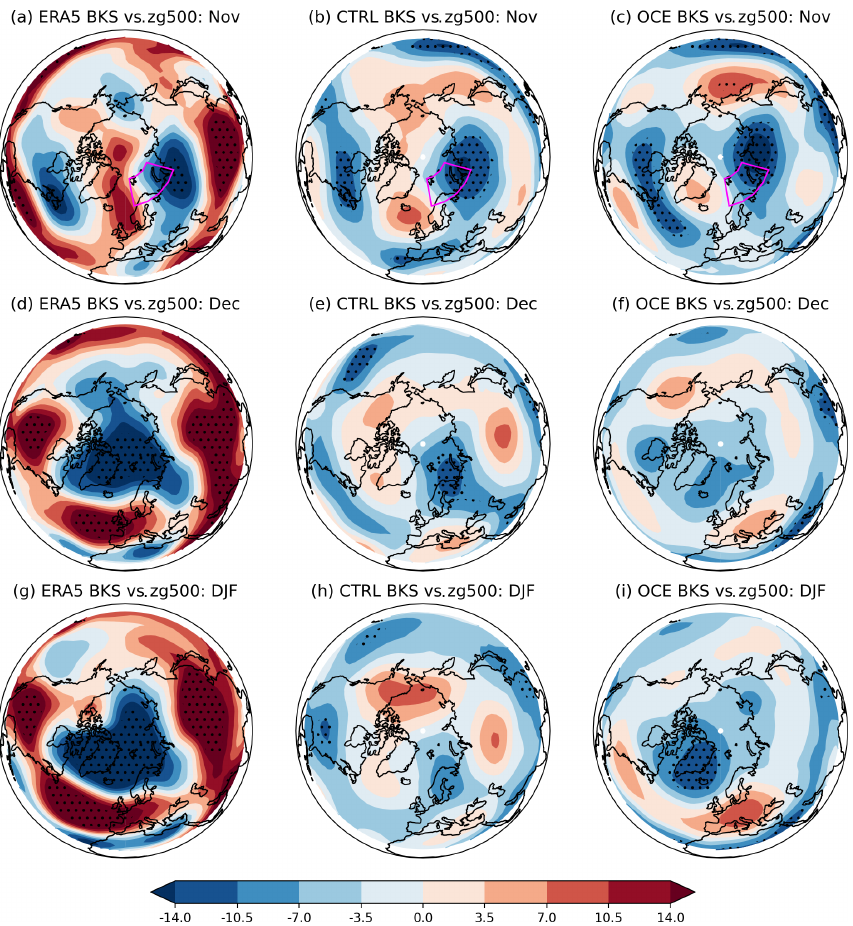
Figure 6. Regression coefficients of November BKS sea ice anomalies against monthly zg500 grid point anomalies in ERA5 for (a) Novem- ber, (d) December, and (g) DJF. The same for CTRL and OCE in (b) , (e) , and (h) and (c) , (f) , and (i) , respectively. The period considered is 1980–2015. Stippling highlights grid points where the associated correlation coefficient is statistically significant ( p < 0 .